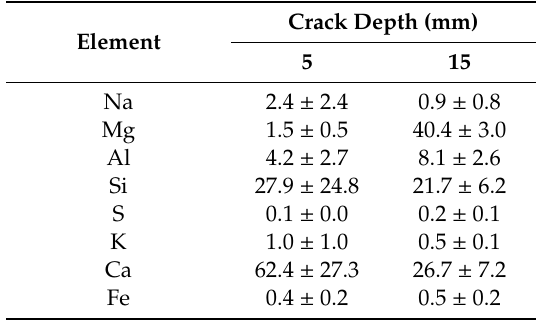
Figure 6. Close up pictures of the crack (filled with white precipitate) in PC-4SF20FA, taken with an optical camera inbuilt in the micro X-ray fluorescence (µ-XRF) instrument. Blurred due to relatively low optical resolution of the instrument. The edges (crack faces) are marked with white lines. Table 8. Average and standard deviation of the µ -XRF composition in atomic% of self-healing products of PC-4SF20FA at a crack depth of 5 and 15 mm.